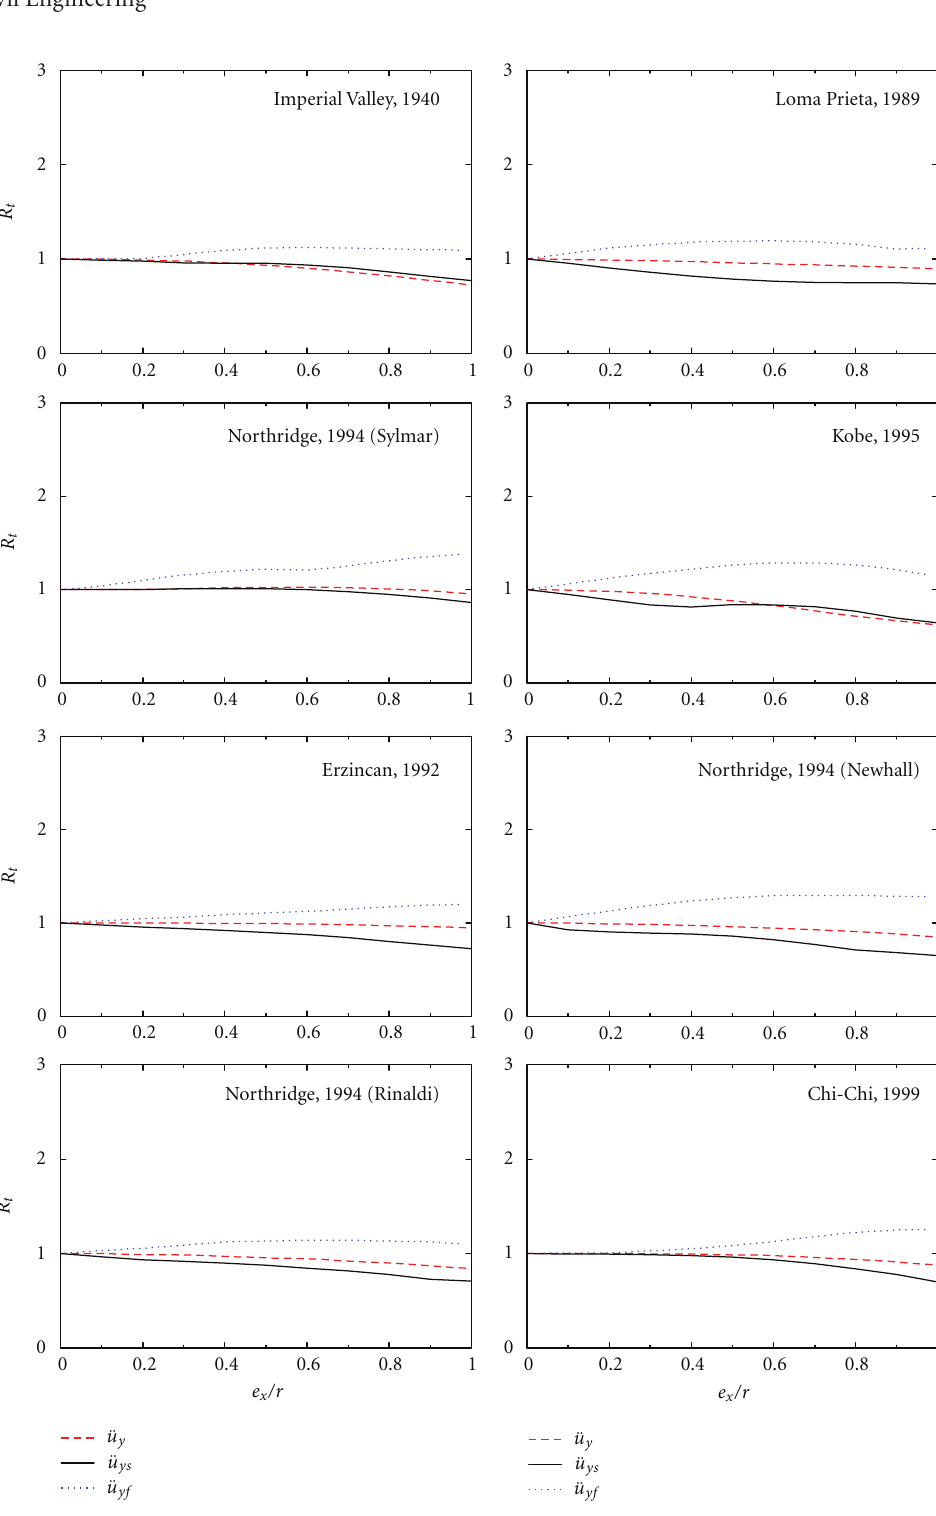
Figure 16: E ff ect of eccentricity on response ratio, R t for various peak accelerations ( T y = 1 s, Ω θ = 2). torsional acceleration, ¨ u θ , increases with increase in e x / r